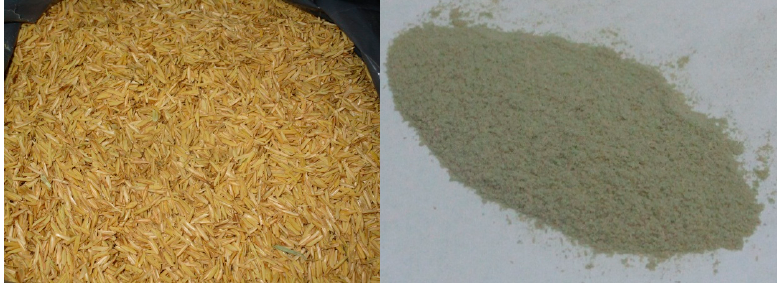
Figure 5. Pretreatment of rice husk ( left image ) to fine sieved powder ( right image ) via milling prior to processing.